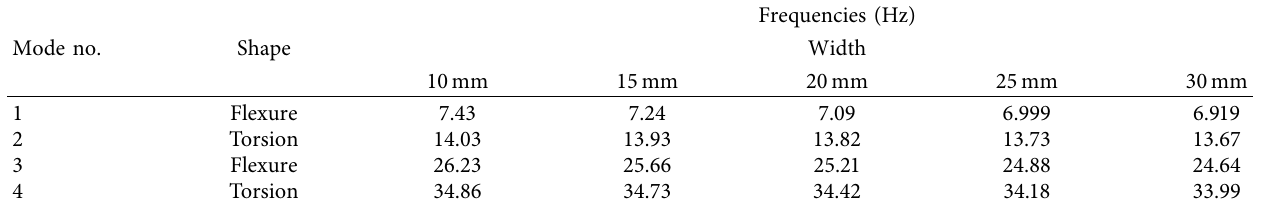
Table 7: Natural vibration frequencies with the width